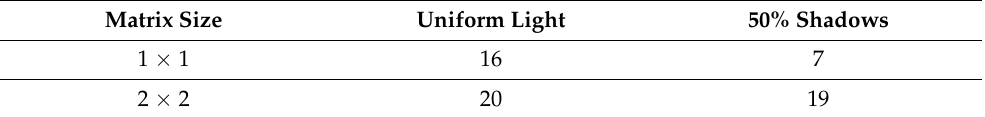
Table 1. Total number of recognitions. Matrix Size